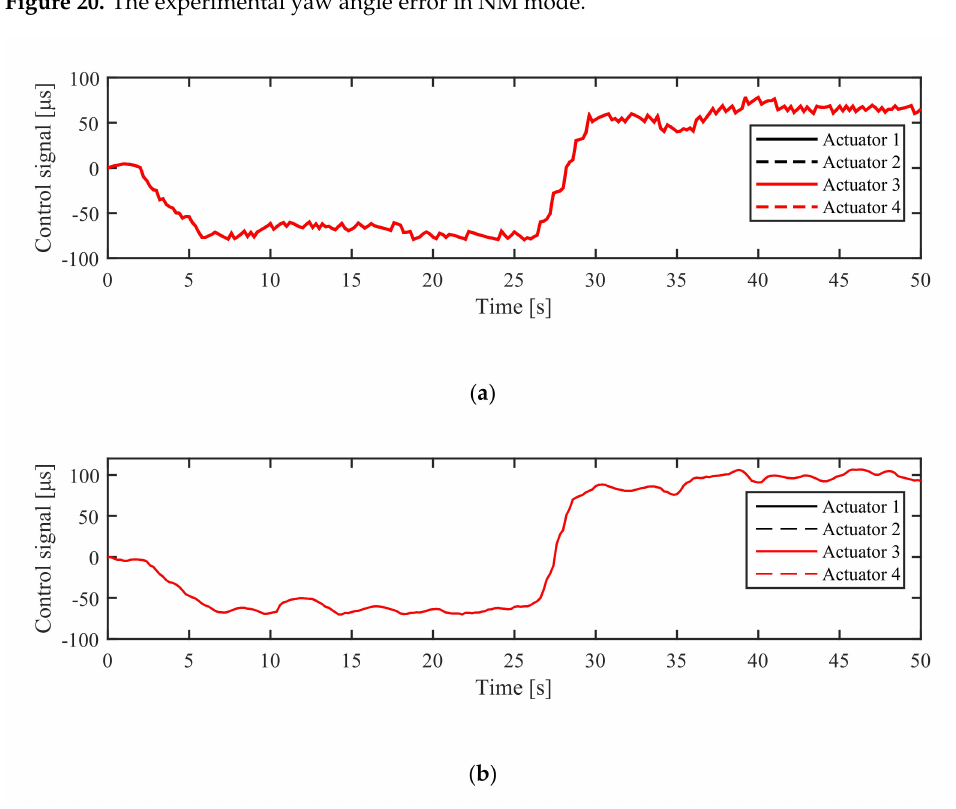
Figure 21. The experimental control signal: ( a ) Proposed controller; ( b )